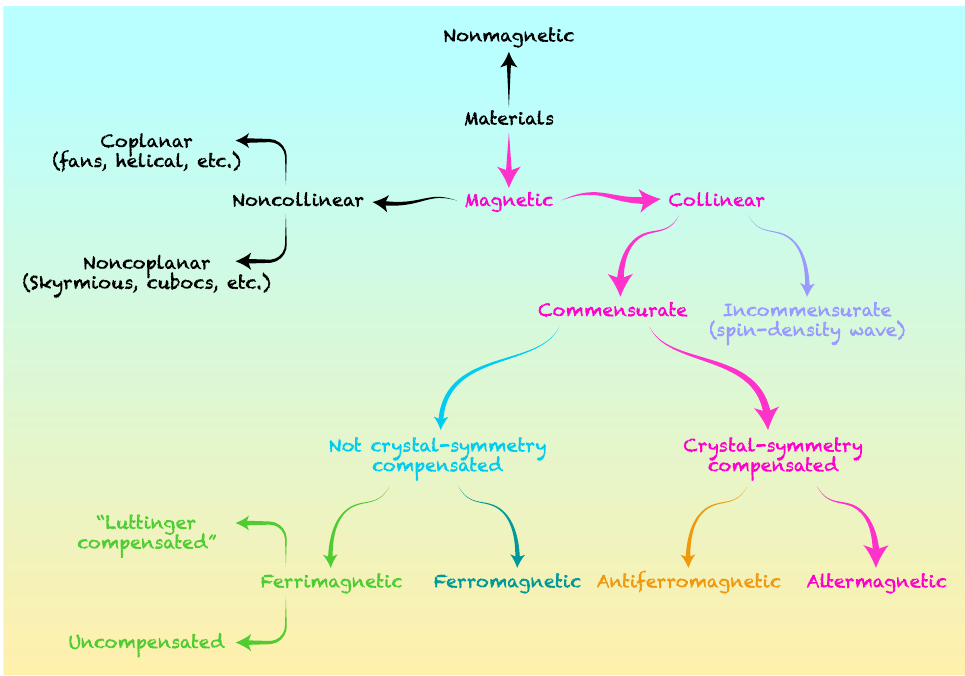
netism as a fundamentally new class of magnetic